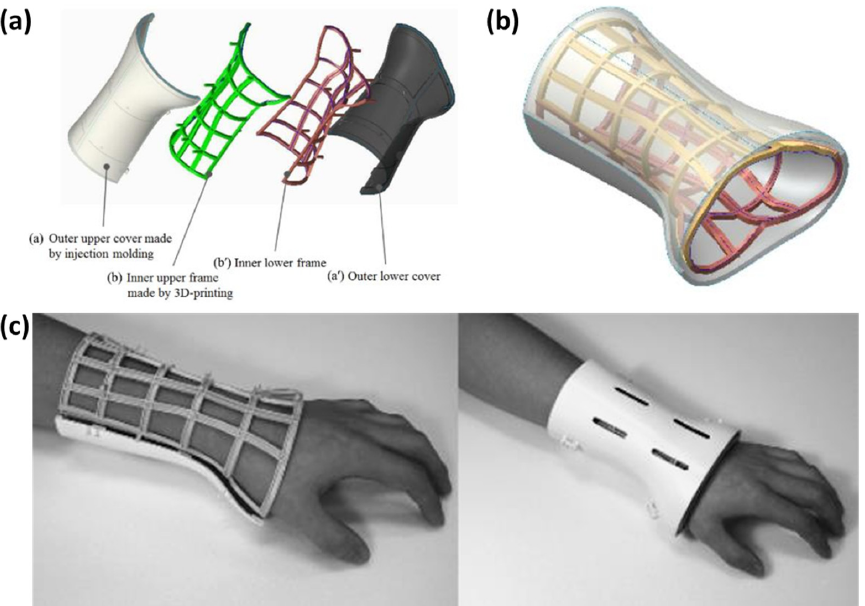
Figure 8. Hand rehabilitation exoskeleton. ( a ) Main concept of the hybrid model for wrist orthosis. ( b ) Combination of the upper cover and inner frame. ( c ) Wearing the new cast [94].